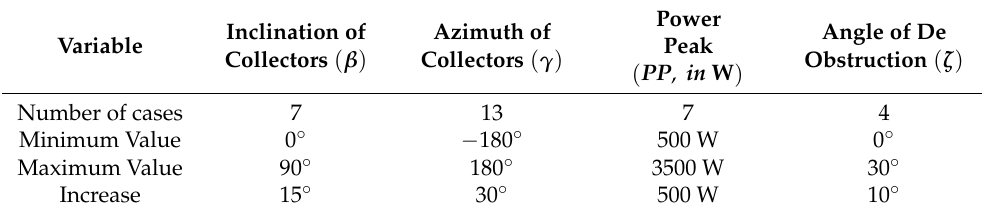
Table 1. Design variables and variation intervals considered for the systematic analysis of PV installations with self-consumption.